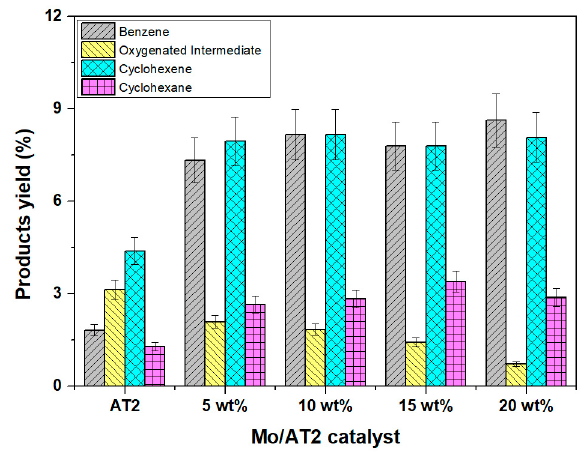
Figure 2. Products yields of HDO of phenol for unpromoted Mo/AT2 catalysts at different Mo loadings at 5.5 MPa, 593 K, and 100 ppm S.